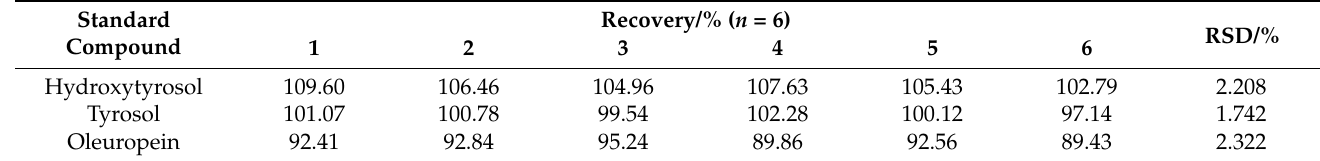
Table 3. Recovery of phenolic compounds standard sample at 280